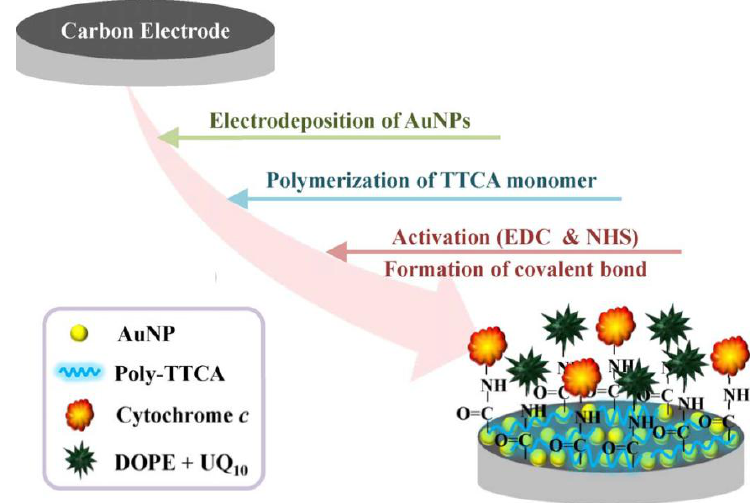
Figure 7. Schematic diagram for fabrication of a biomimetic membrane. Reprinted with permission from [46], © 2009